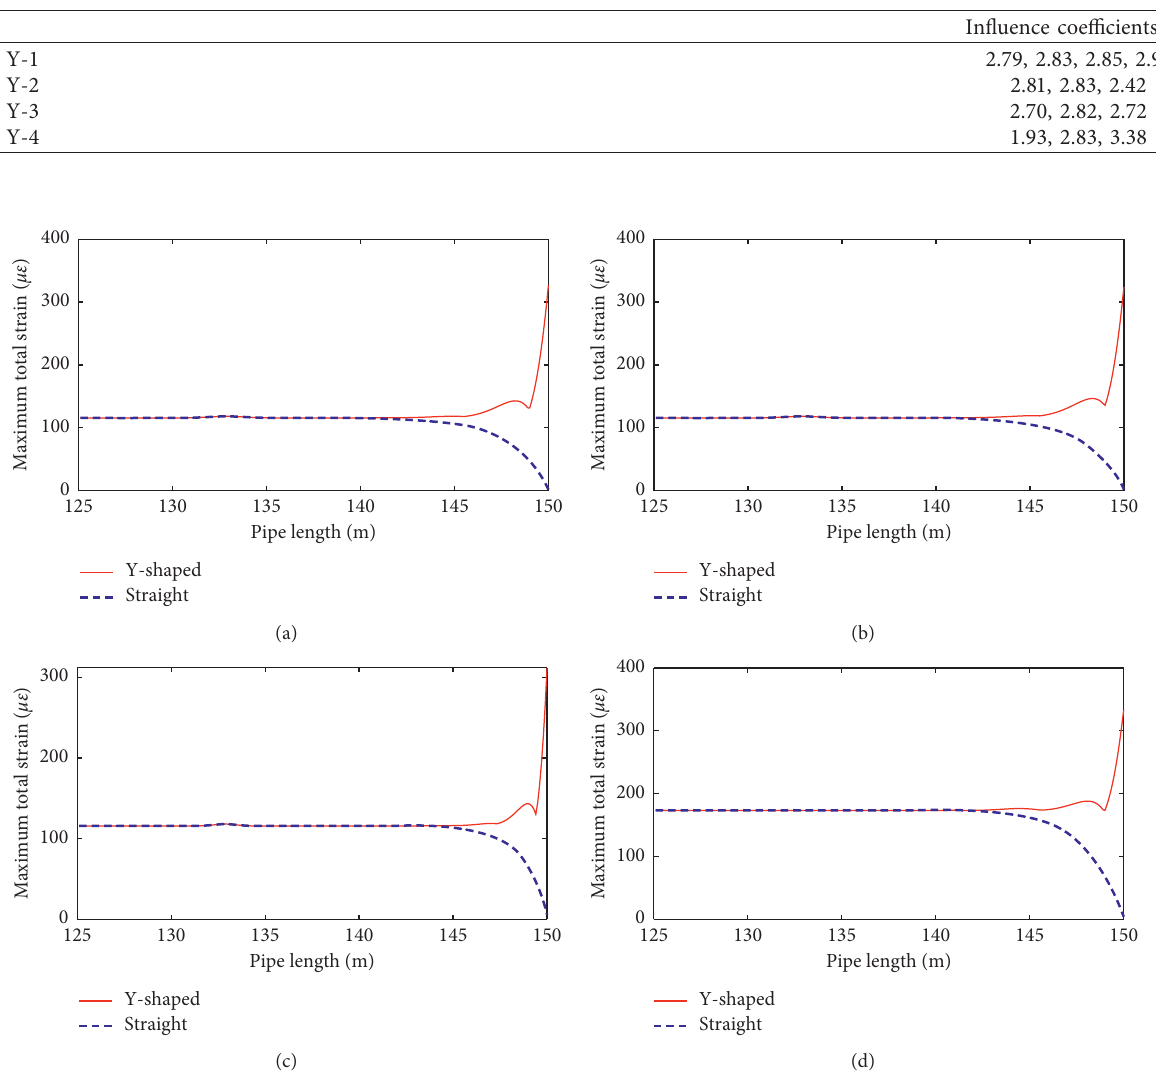
Table 18: Influence coefficients of Y-shaped connection in different cases.